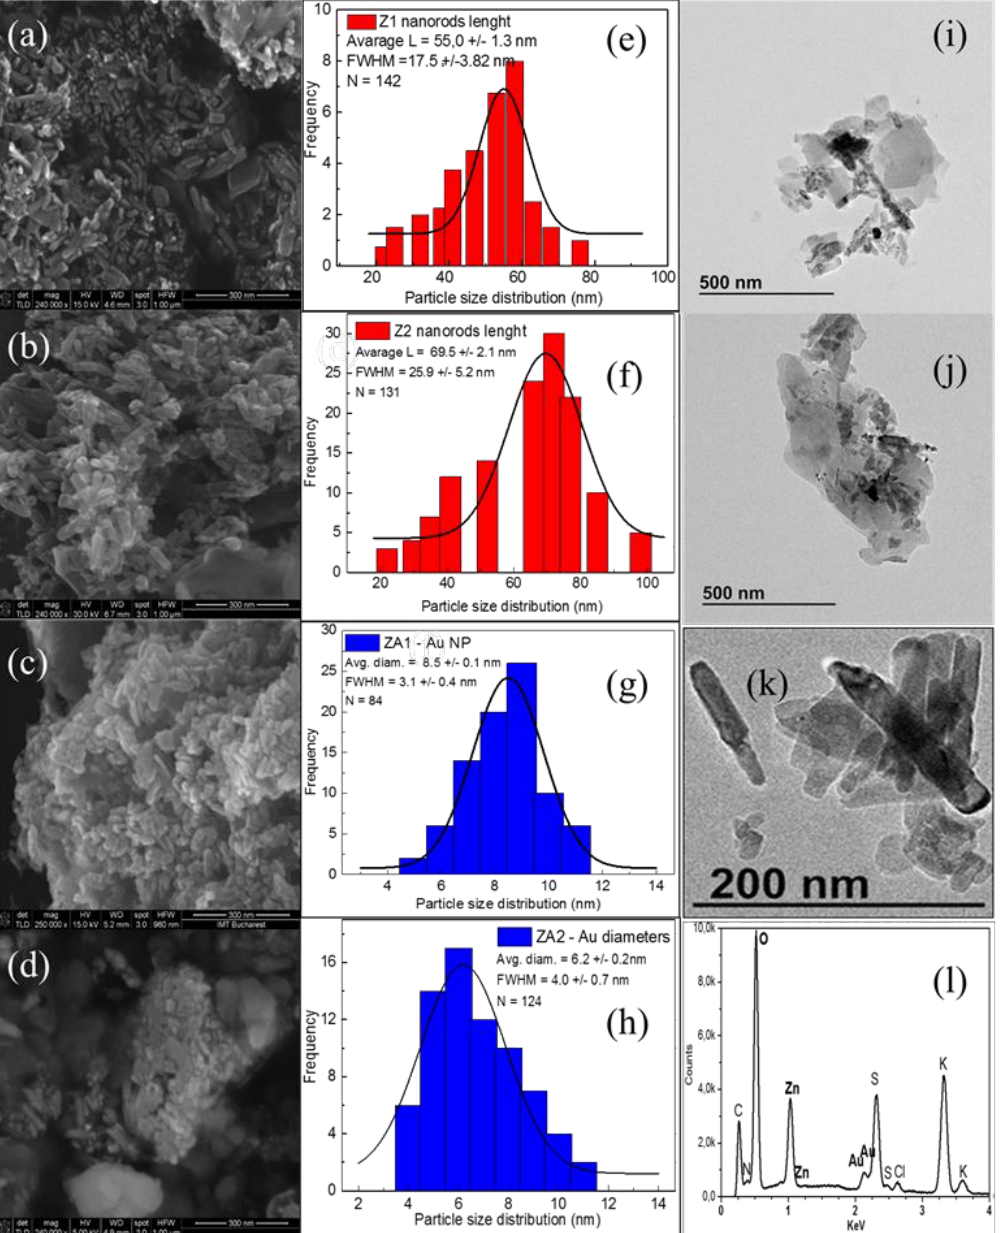
Figure 3. SEM images of the ( a ) Z1, ( b ) Z2, ( c ) ZA1, and ( d ) ZA2 samples; Histogram distributions of the ( e ) Nanorods length in Z1, ( f ) Nanorods length in Z2, ( g ) Au NPs diameters in ZA1, and ( h ) Au NPs diameters in ZA2, ( i ) TEM image of ZA1, ( j ) TEM analysis of ZA2; ( k ) TEM magnification of sample ZA2 ( l ) EDX analysis of ZA2